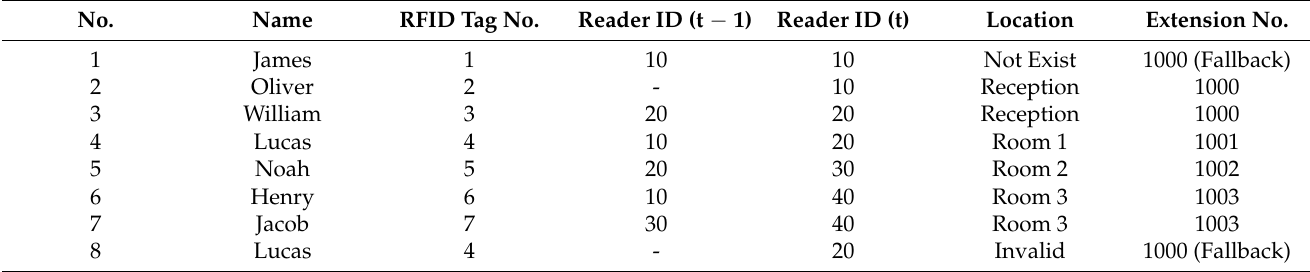
Table 4. Entering and exiting illustration